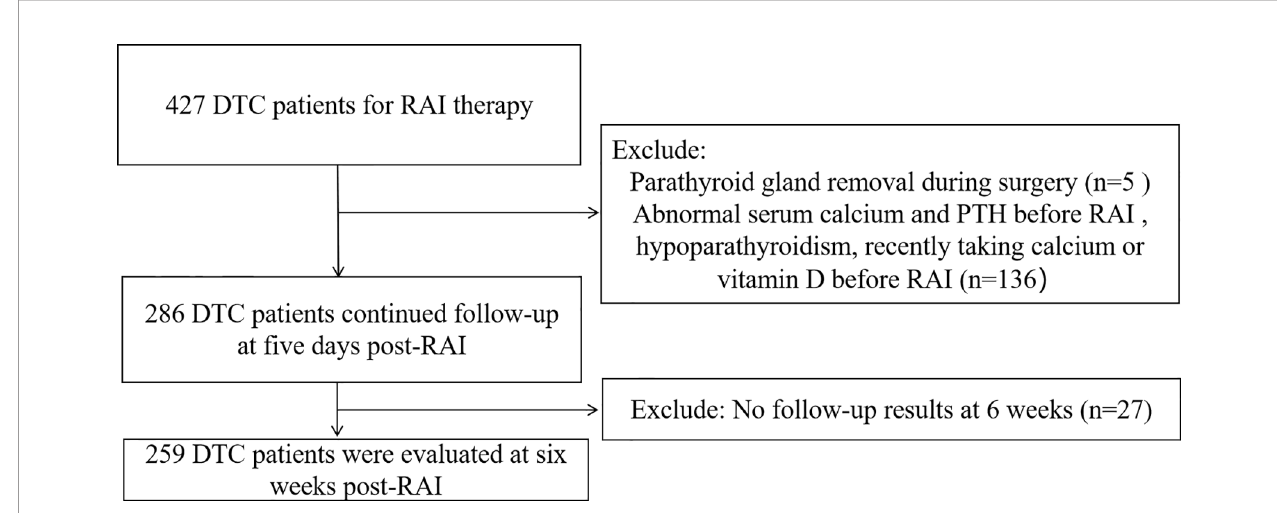
FIGURE 1 | Flowchart of the